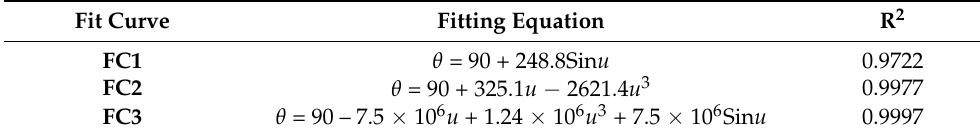
Figure 6. Different fitting curves (FC) used to find the relationship between the unit cell angle vs. the dimensionless lateral displacements using the elasticity theory . The corresponding fitting equa- tions are shown in Table 1. Table 1. Fitting curves (FC) and corresponding errors. Table 1. Fitting curves (FC) and corresponding